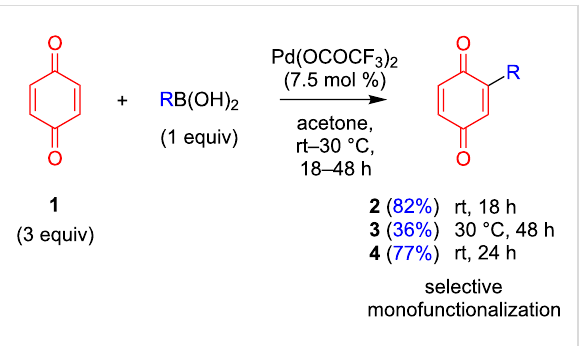
Scheme 3: Synthesis of 5 via double Suzuki coupling.